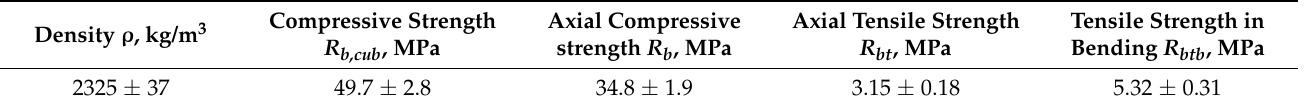
Table 4. Results of experimental studies of the physical and mechanical characteristics of vibrated concrete.